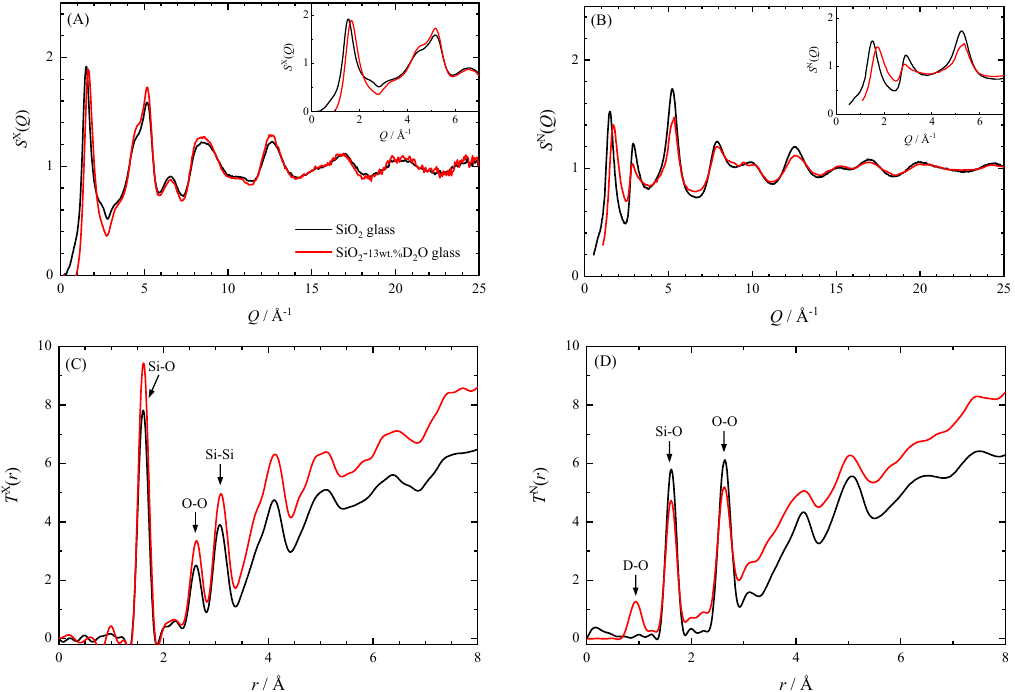
Figure 3. X-ray and neutron di ff raction data of the hydrous SiO 2 glass and the anhydrous SiO 2 glass at ambient conditions. ( A ) The X-ray structure factor S X ( Q ), ( B ) the neutron structure factor S N ( Q ), ( C